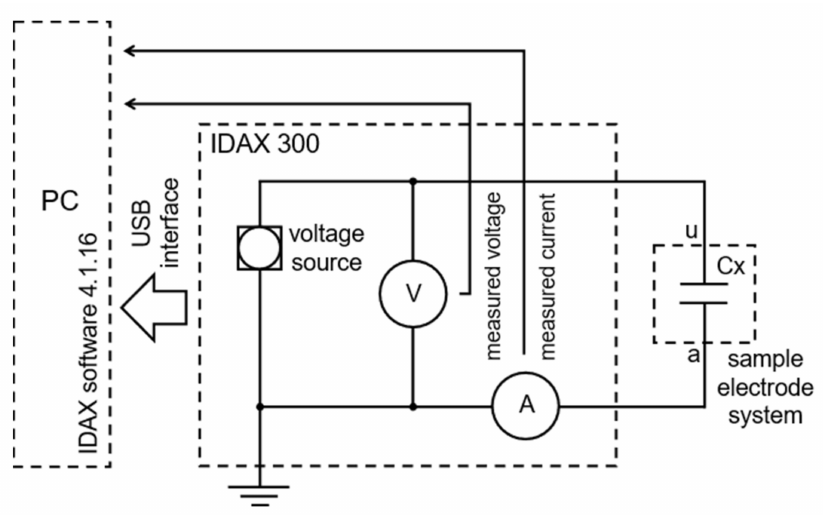
Figure 2. Wiring diagram of the experimental measuring